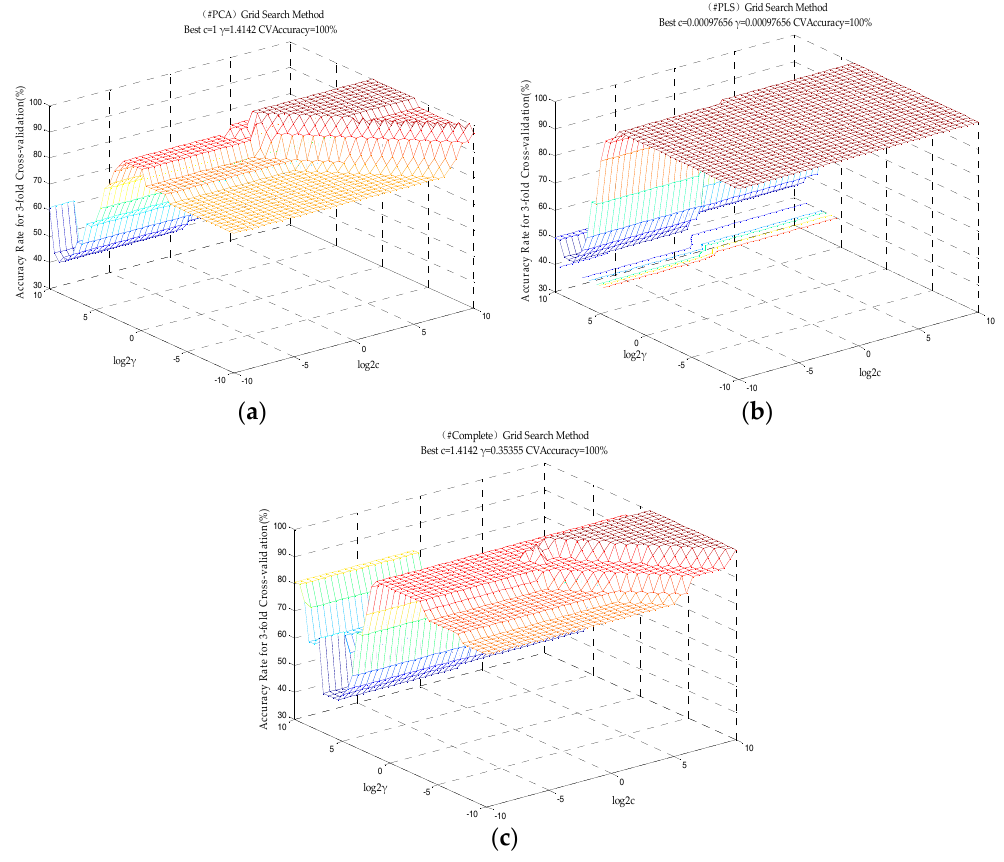
Table 2. Sensors 2017 , 17 , 285